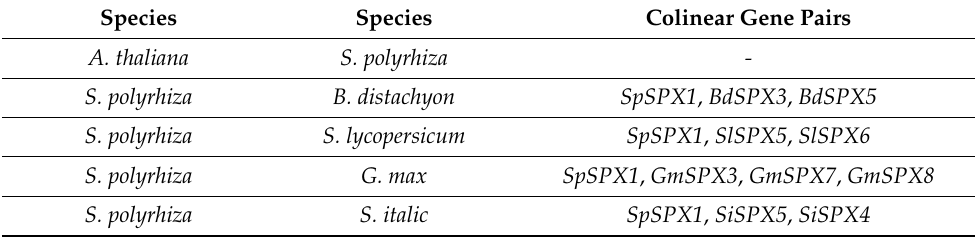
Figure 3. Frequency of main cis -elements in the 2 kb promoter region of 160 SPX genes. Table 3. Identified colinear gene pairs between S. polyrhiza and other seven plant